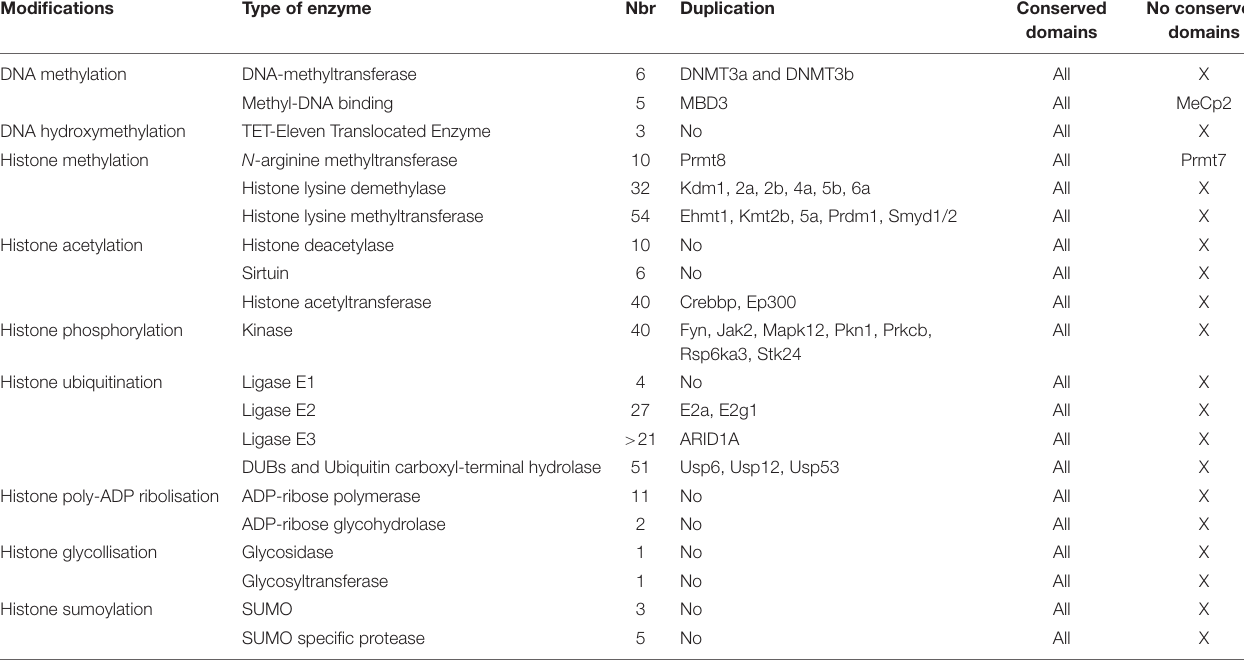
TABLE 1 | Epigenetic toolkit of threespine